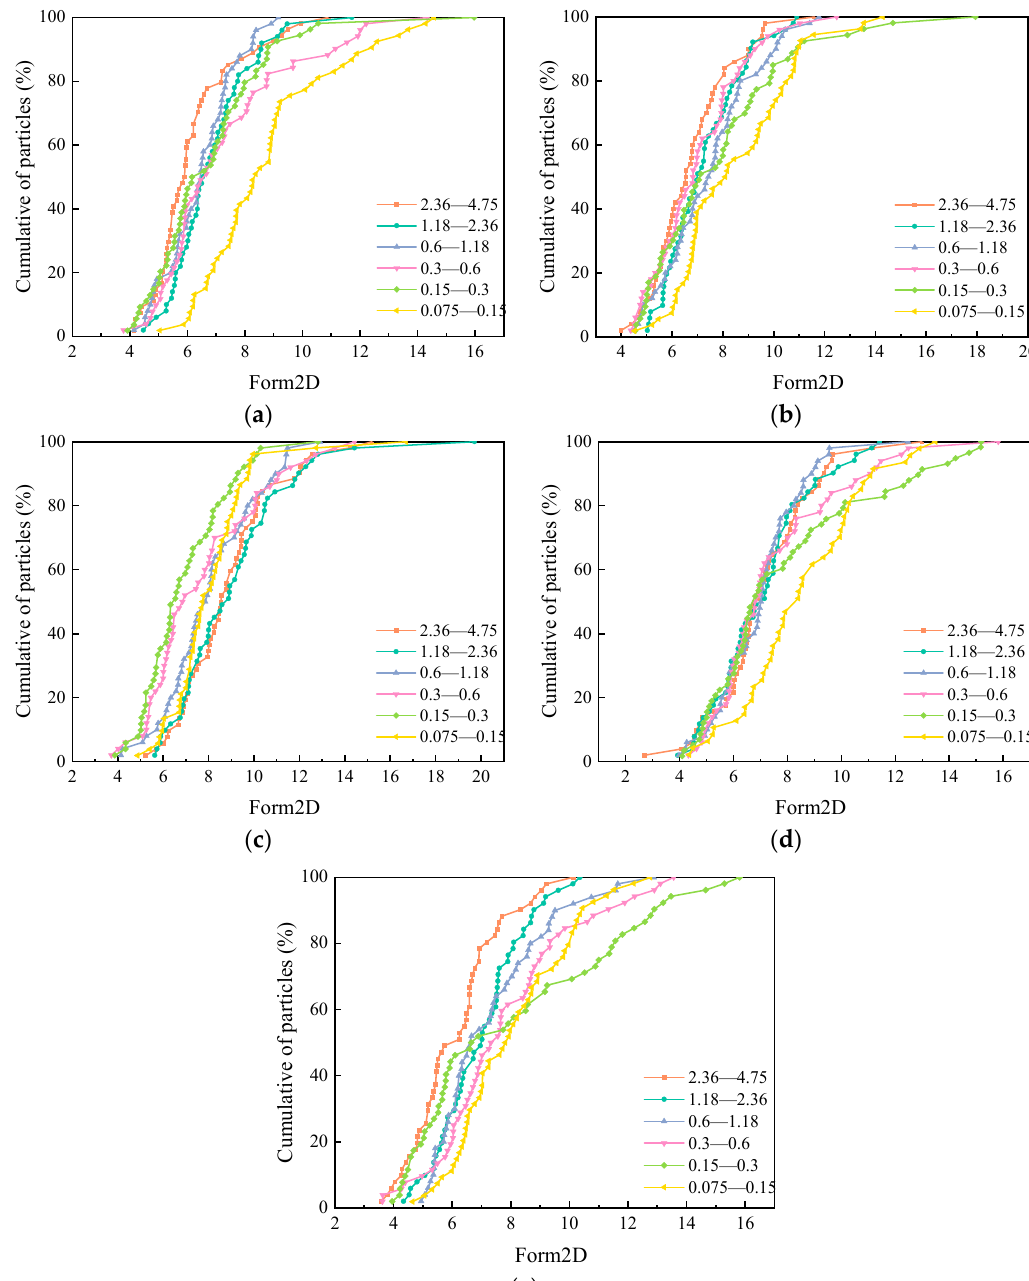
Figure 9. The form2D of five manufactured sands: ( a ) MSA, ( b ) MSB, ( c ) MSC, ( d ) MSD, ( e ) and MSE. The average form2D of each sand is shown in Figure 10. Unlike angularity, there is no clear law on a variation in form2D values concerning particle size. The form2D values of the different manufactured sands in the same particle size range also show different trends. Comparing the average form2D in the range of 0.075–4.75, MSC is the largest, followed by MSD, MSB, MSE, and MSA. Combining angularity and form2D, MSA has the closest two-dimensional shape to a circle and MSC has the most irregular shape.